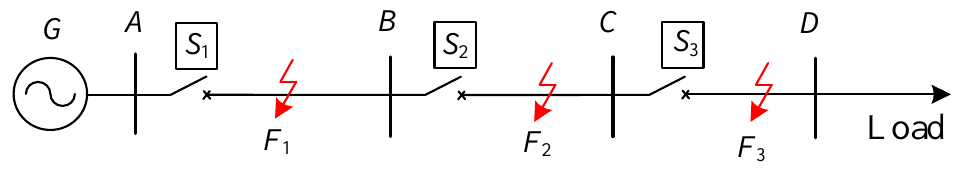
Figure 1. Typical grid structure.